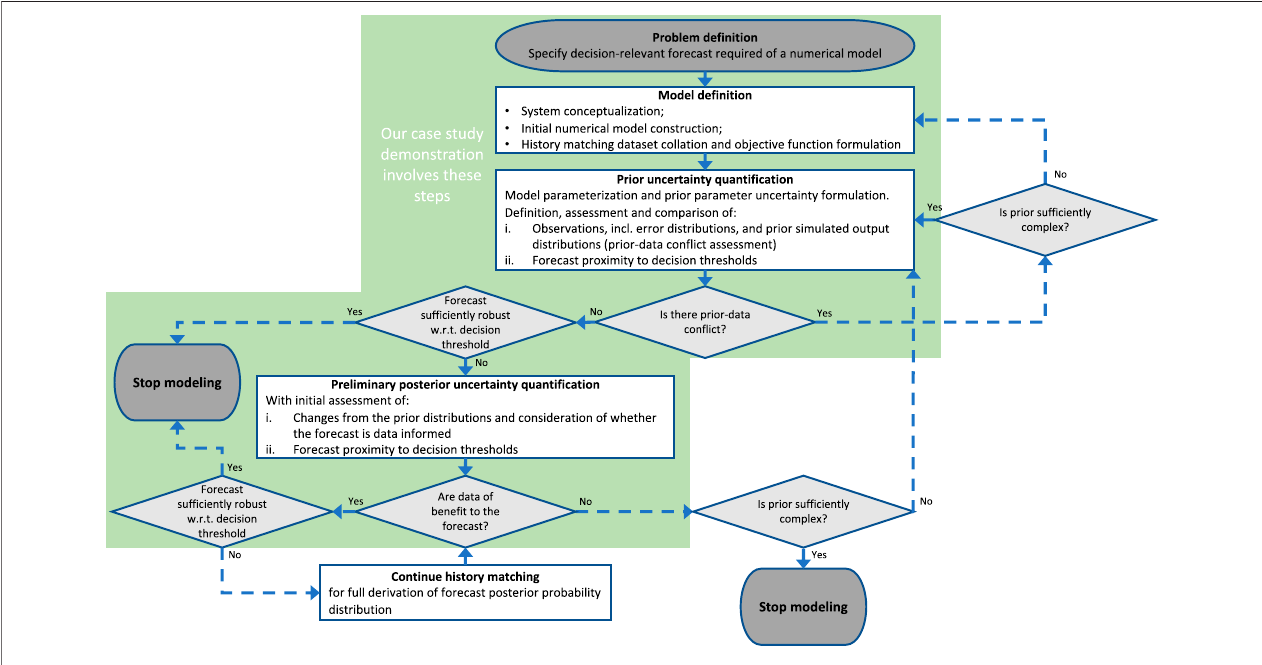
FIGURE 1 | Graphical presentation of the proposed decision support modeling work fl ow, which incorporates uncertainty quanti fi cation at an early stage before undertaking more comprehensive history matching. The steps involved in the case study presented herein are highlighted with the green background.